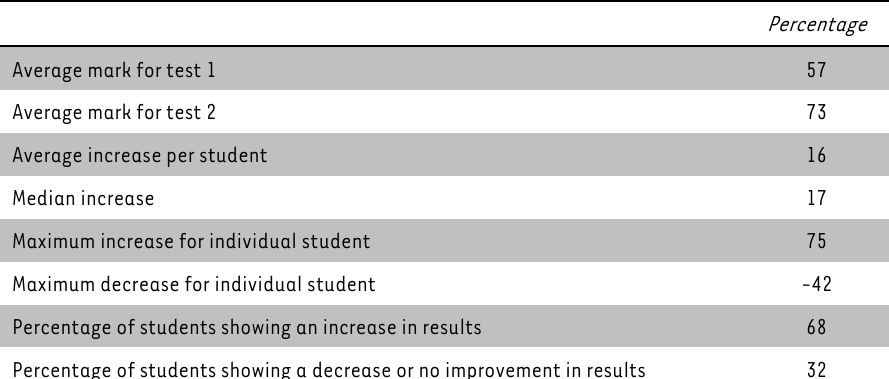
TABLE 1: Results of written